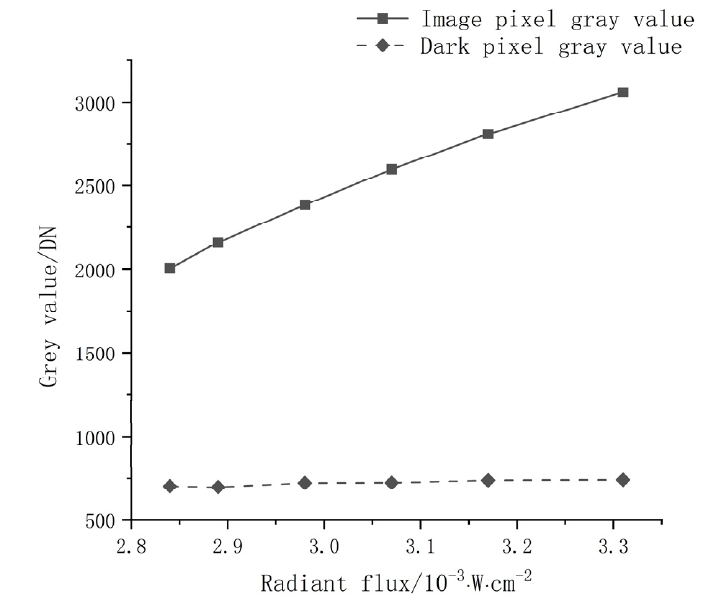
Figure 7. Radiometric calibration curves of imaging pixels and dark pixels.